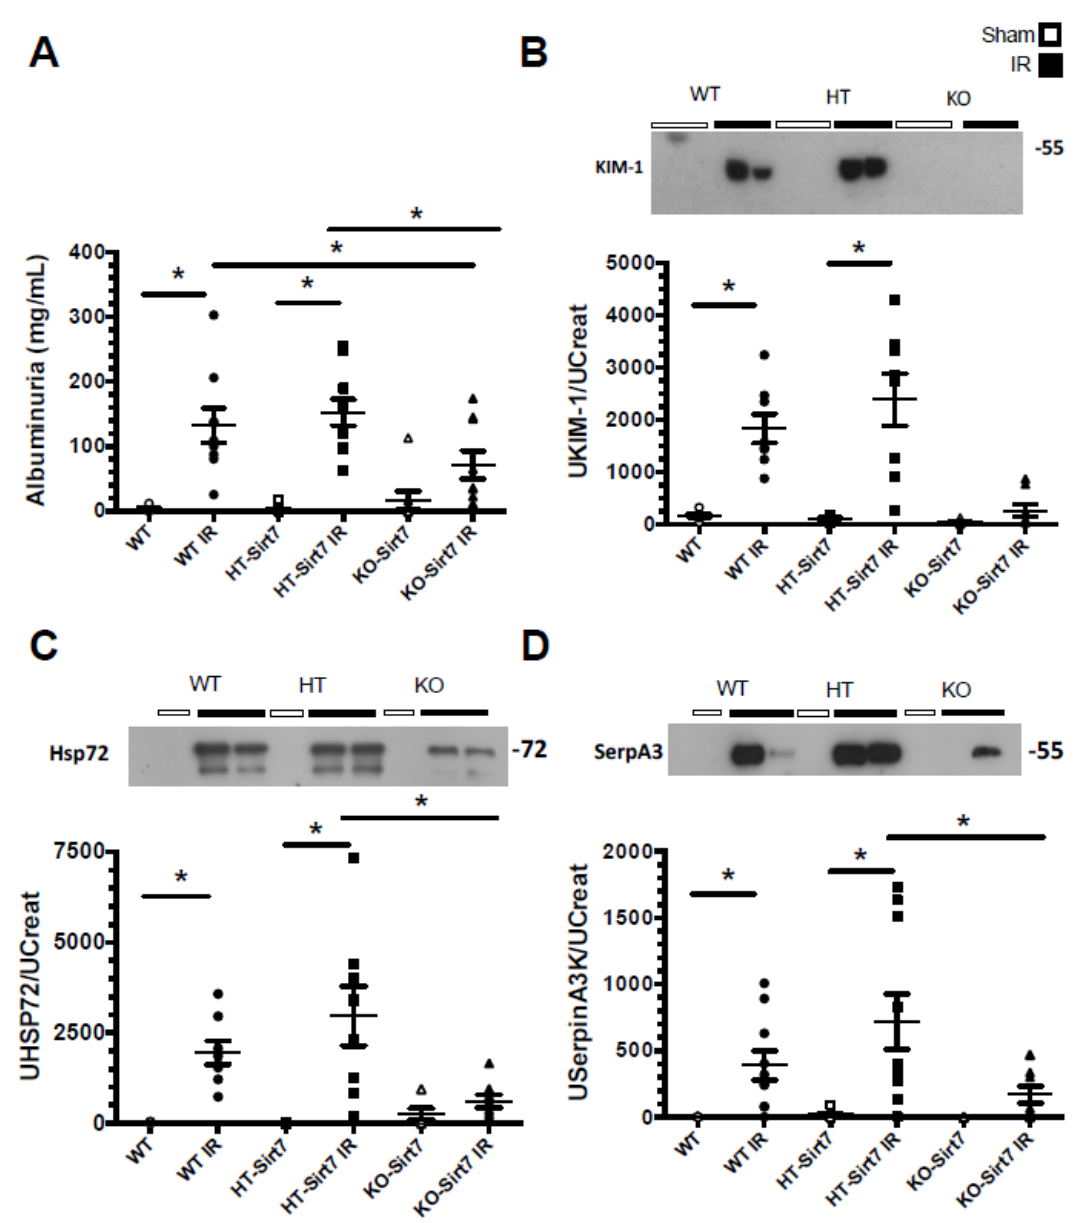
Figure 2. Sirt7 deficiency prevented kidney damage. ( A ) Albuminuria/Urinary Creatinine (UCr) ratio, ( B ) UKIM-1/UCr ratio ( C ) UHSP72/UCr ratio, and ( D ) USerpinA3/UCr ratio. White circles represented WT, Black circles, WT+IR, White squares, HT-Sirt7, Black squares. HT-Sirt7+IR, White triangles. KO-Sirt7, and Black triangles. KO-Sirt7+IR. n = 5 – 10 per group. * p < 0.05 vs. the respective control group as stated.